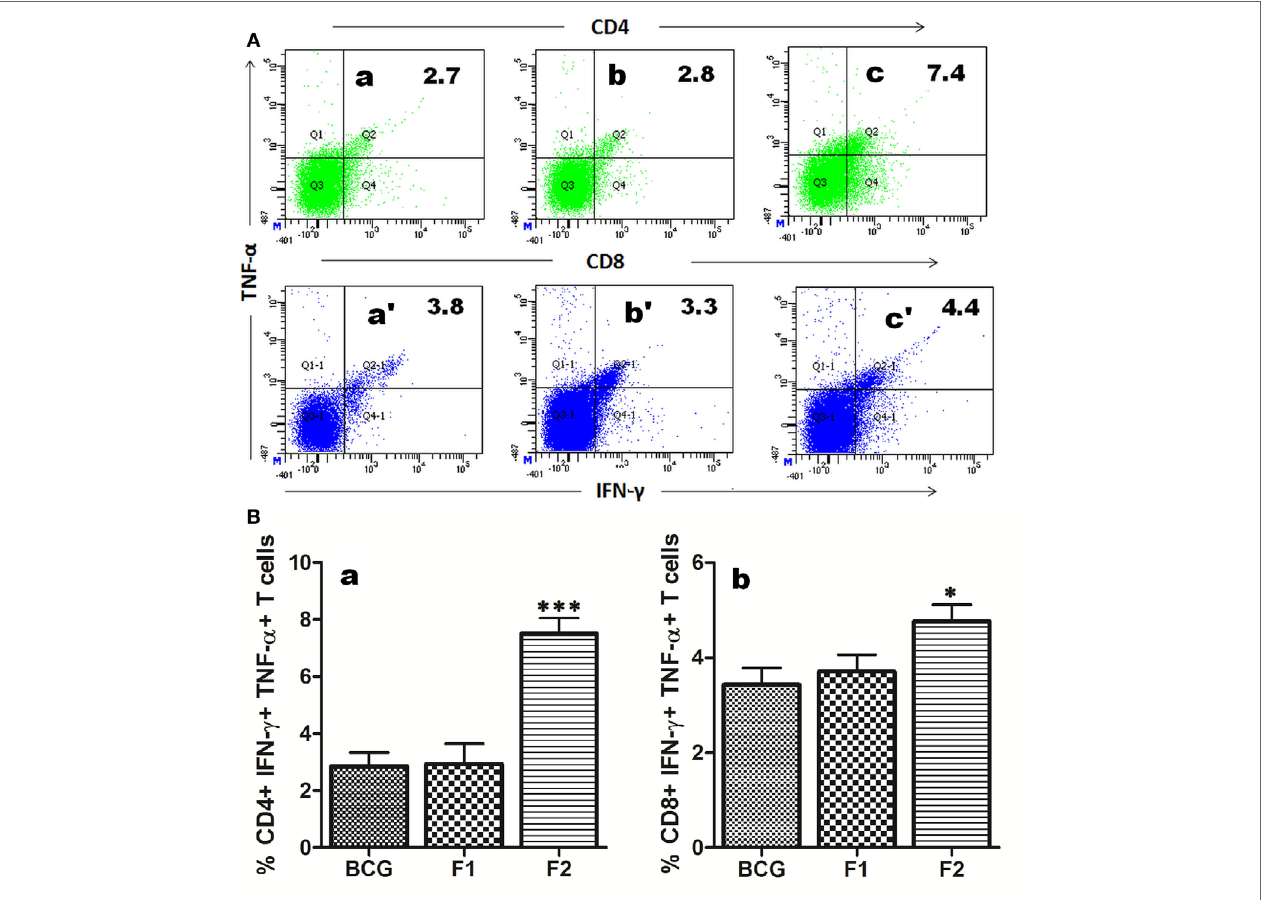
FigUre 6 | Immunization with aggregated Ag85B results in expansion of polyfunctional T cells in immunized mice. T cells isolated from mice immunized with Bacillus Calmette–Guerin (BCG), Ag85B-IFA (F1), and aggregated Ag85B (F2) were stimulated ex vivo with corresponding antigens for 24 h and stained for intracellular IFN- γ and TNF- α . (a) Representative FACS dot plots denoting cumulative frequencies of CD4 + and CD8 + polyfunctional T cells. Cells co-expressing IFN- γ and TNF- α on immunization with BCG (a and a ′ ), native Ag85B-IFA (F1) (b and b ′ ), and aggregated Ag85B (F2) (c and c ′ ). (B) Bar graphs depicting percent population of IFN- γ , TNF- α co-expressing CD4 + (a), and CD8 + (b) polyfunctional T cells. The cells were isolated from splenocytes of various immunized groups of mice at 1 week post booster. Dot plots are representative of at least three animals for each group. The data were analyzed by employing one-way ANOVA followed by Bonferroni’s multiple comparison test and shown as means ( ± SD) of three independent determinants, where p < 0.05(*), p < 0.01(**) and p < 0.001(***) were considered